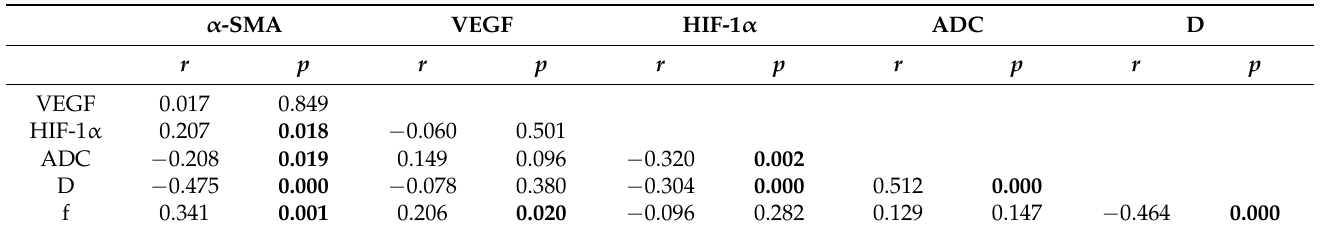
Table 3. The correlation between quantitative MRI parameters and the histopathology of PDAC by Pearson correlation